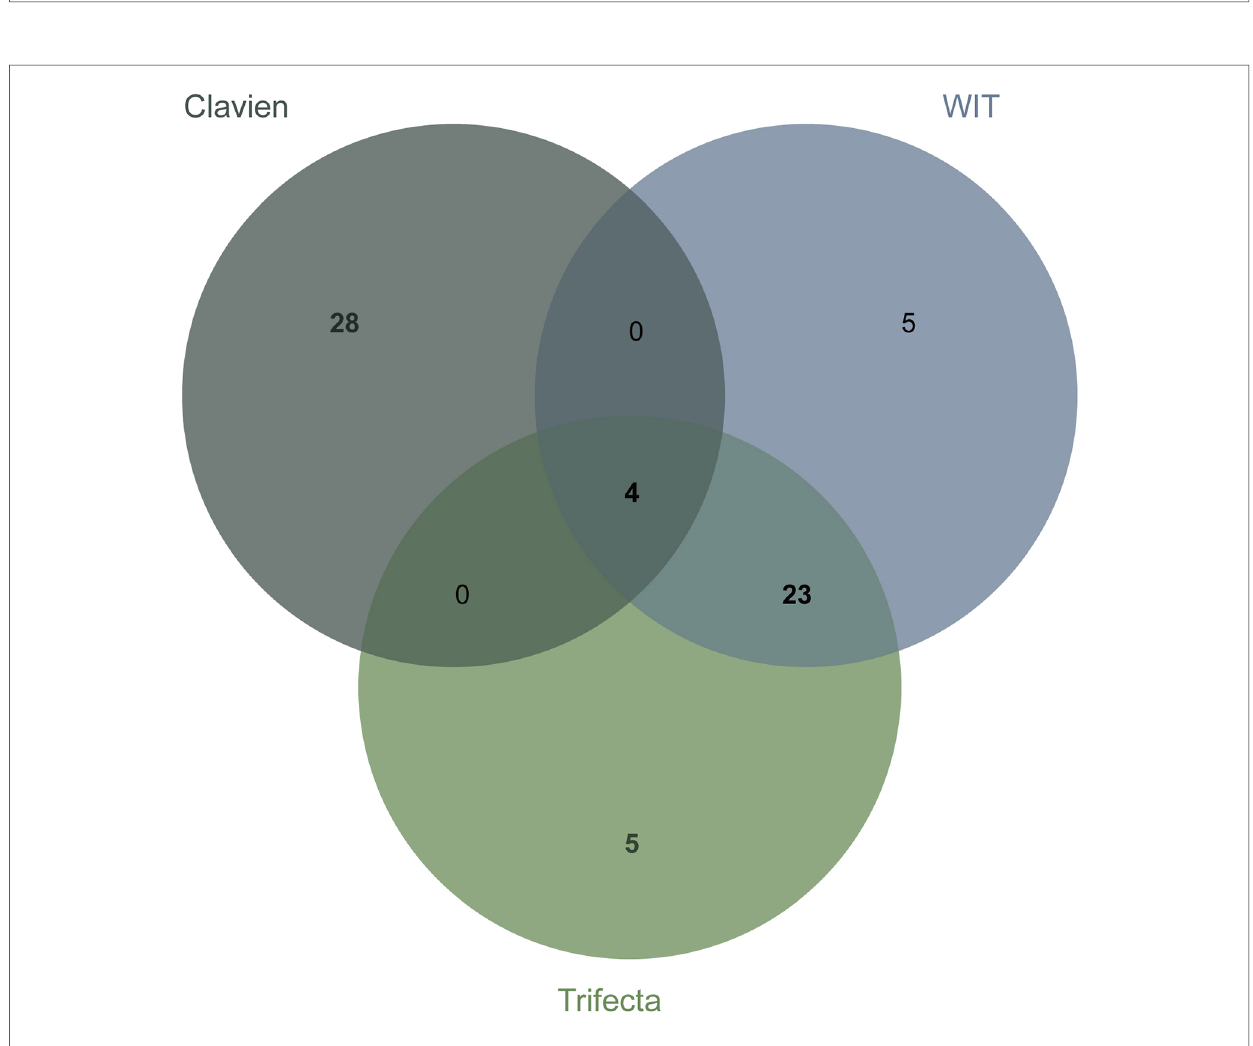
FIGURE 3 Identifying combinations of key elements by Venn